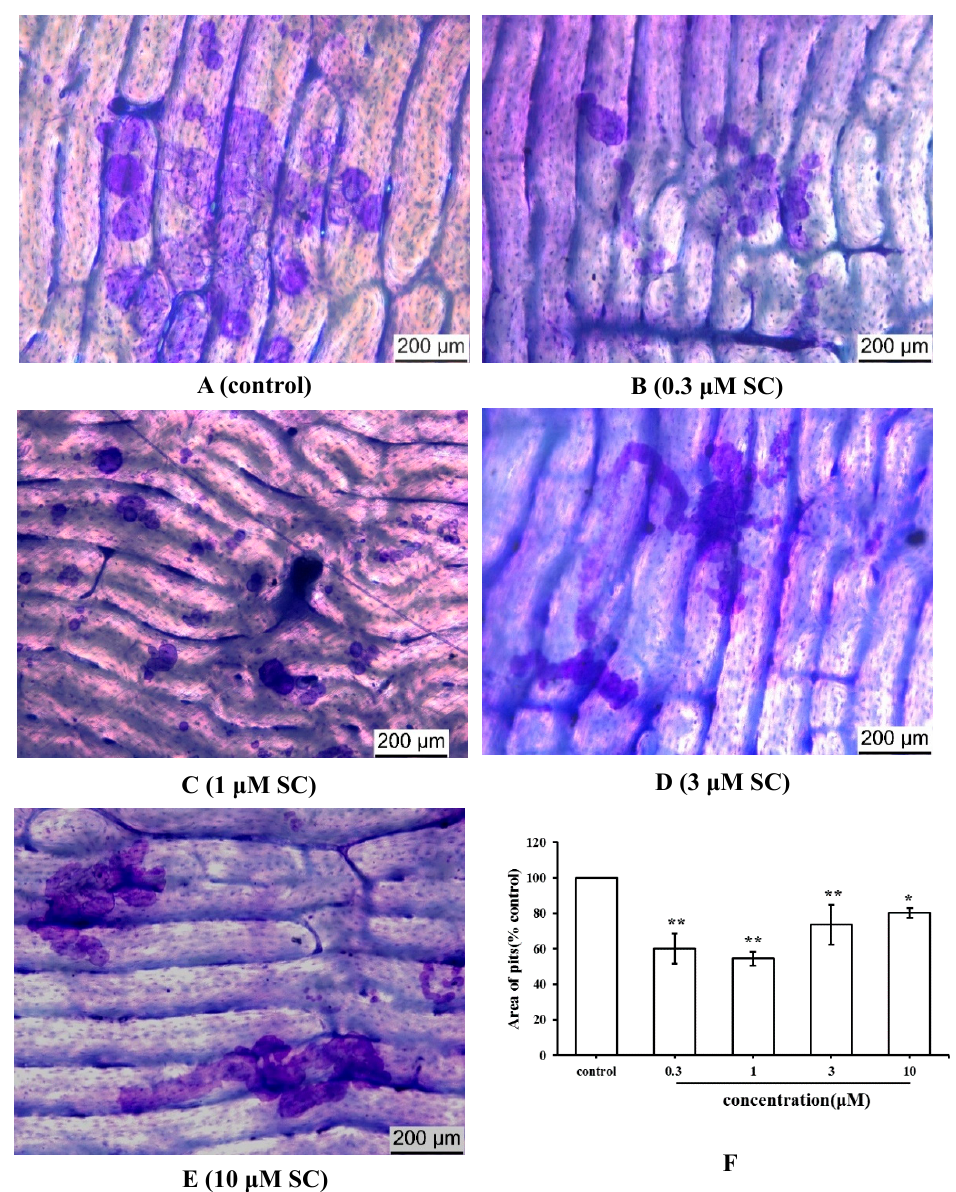
Figure 5. The bone resorption pits formed by rabbit osteoclasts after eight days of incubation (* p < 0.05, ** p < 0.01 compared with the control group). ( A – E ) Pits on the bone slices stained with toluidine blue (×100). ( F ) The ratio of pits area the SC group and the control group.